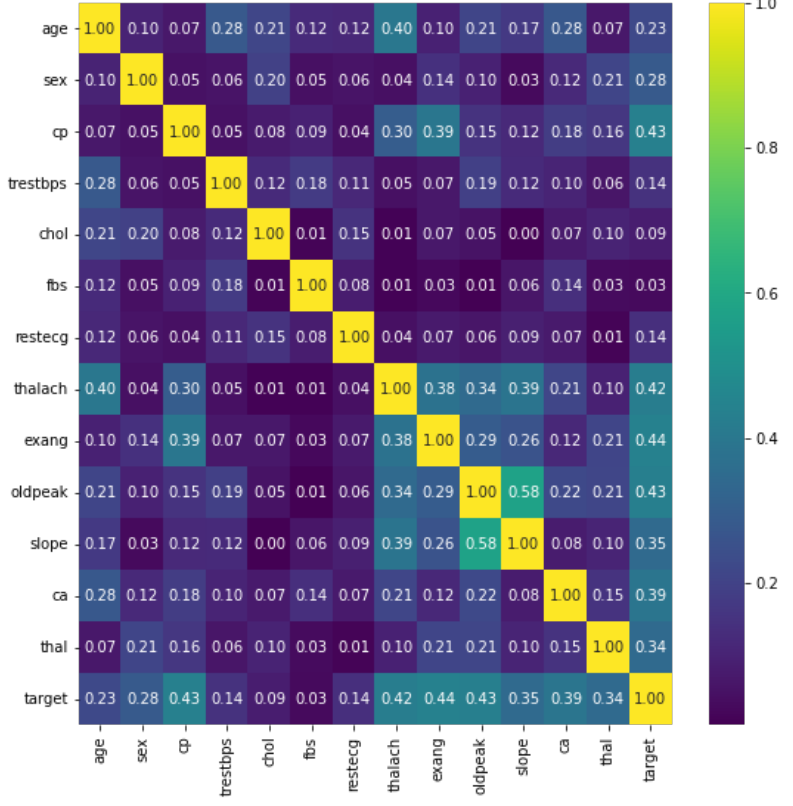
Figure 3. Statistical description of heart disease dataset.